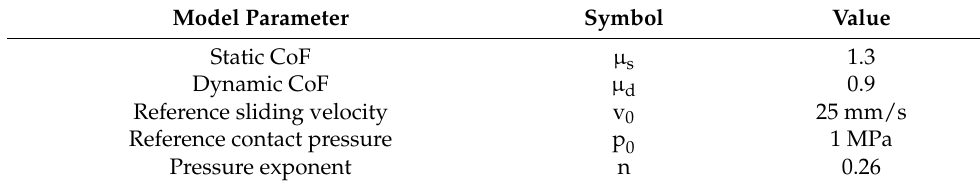
Table 4. Model parameter for friction